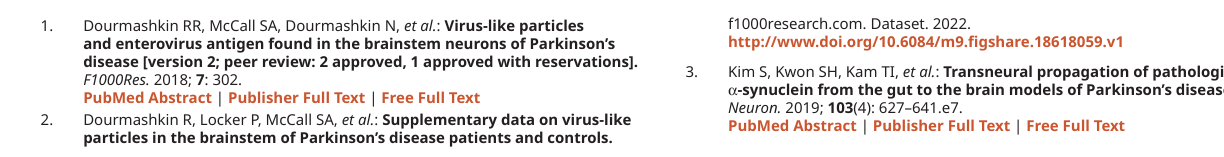
• Control Figure 1. Ribosomes in Nissl body, and mito- chondrion. Measurements, Image 9.090117. Control Figure 2. Control case. Ribosomes in a Nissl body. Measurements, image 9.08039. Control Figure 3. Control case. Nissl body. Image 10.09b004. Control Figure 4. Control case; a group of ribosomes in a neuron in the basal ganglia. Measurements, image 10.09015. Control Figure 5. Control case; a group of ribosomes in a Nissl body in the same area as above. Image 10a09009. Control Figure 6. Measurements. Control case, as above; endoplasmic reticulum in the cytoplasm of a neuron. Image 10c.09011. Control Figure 7. A case that was reported as being a control case. VLP characteristic of PD are shown (arrows). Image 11.09b001. Control Figure 8. In a same case as in Figure 9, an intracellular Lewy body. Image 11.09006. Control Figure 9. A control case, showing cytoplasm and nucleus. Image 12.09015. Control Figure 10. Control case. Image 1209b004.